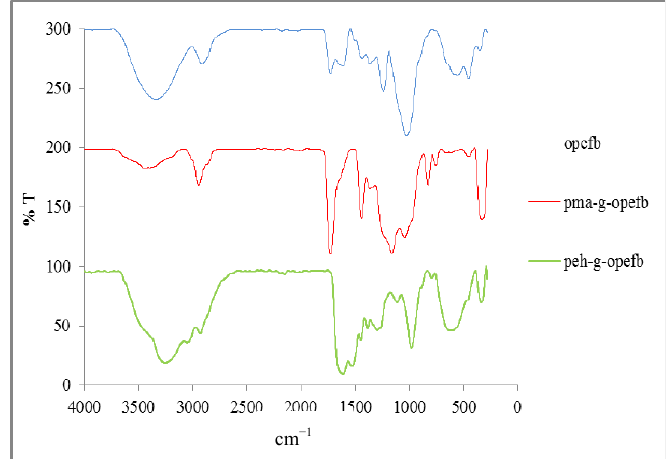
Figure 1. The FTIR spectra for opefb, pma-g-opefb, and